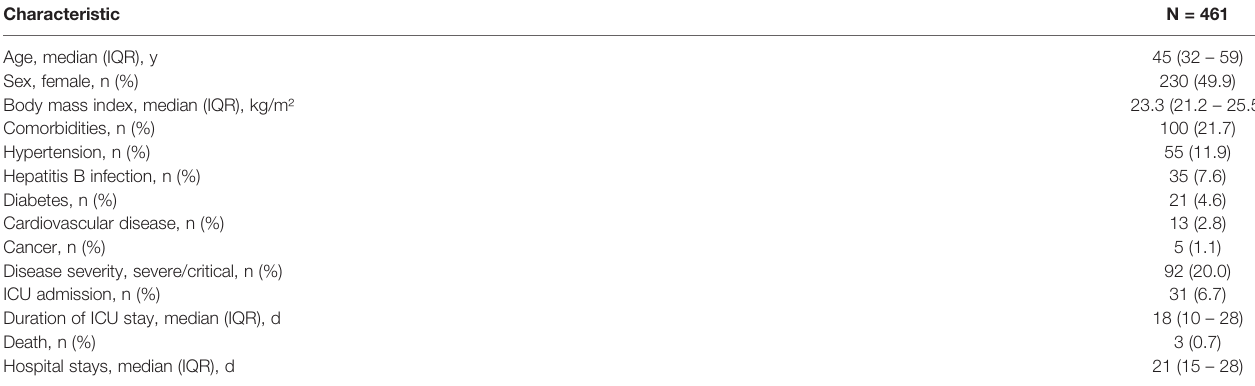
TABLE 1 | Baseline Characteristics in Included Patients with COVID-19.